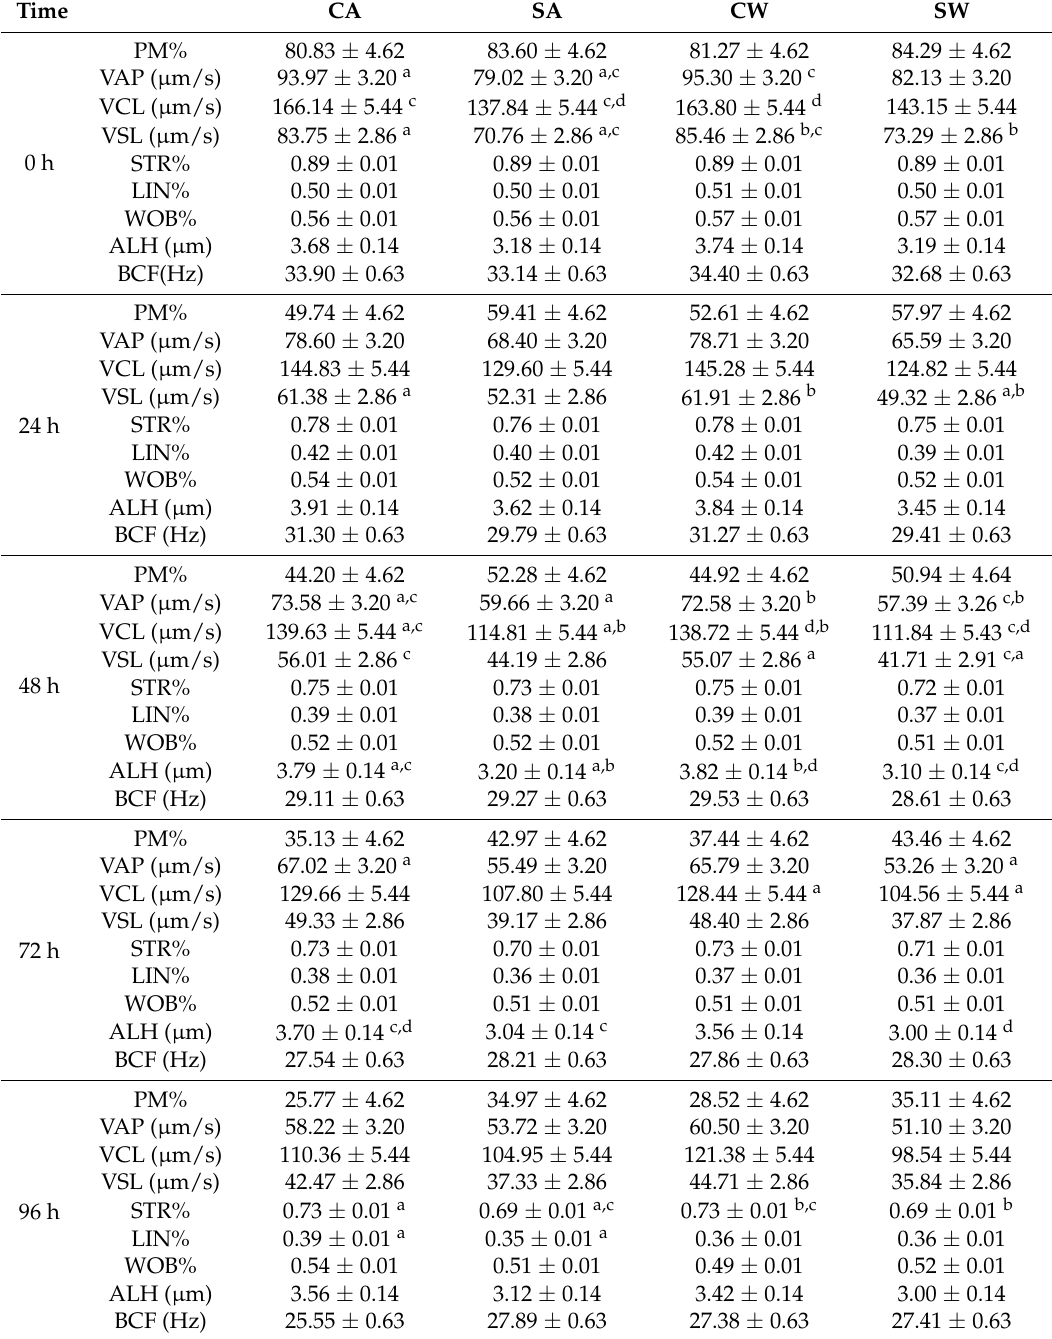
Table 1. Sperm kinematics for control and treatment groups, with and without antibiotics at 0 to 96 h (Least Squares Means ± Standard Error; n =